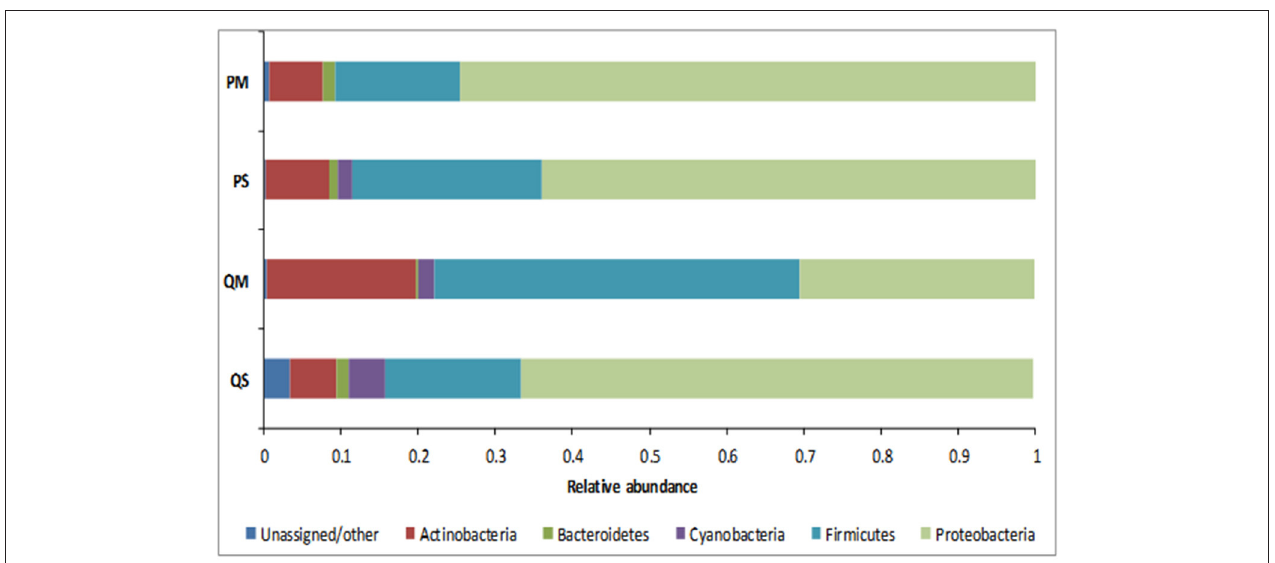
Frontiers in Microbiology |